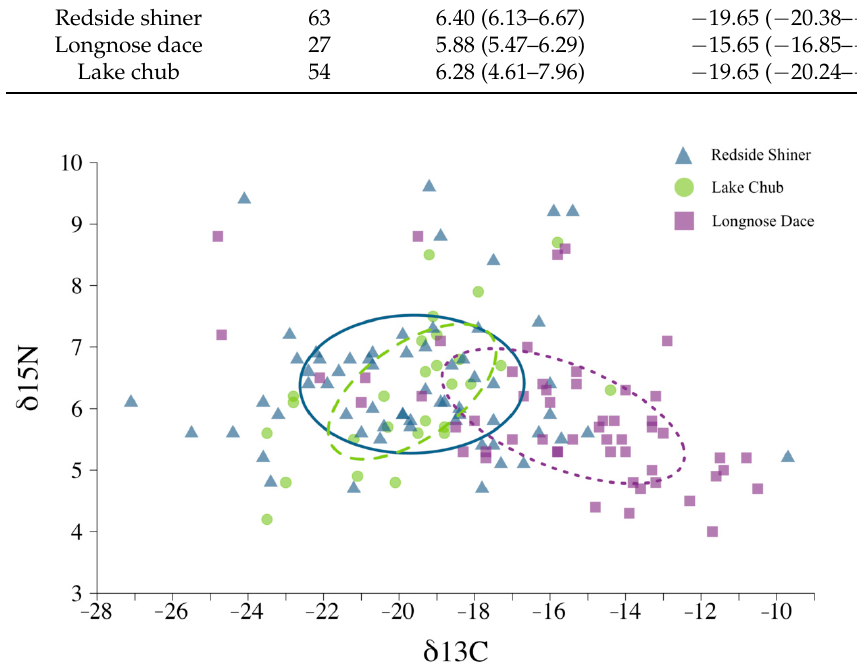
Figure 2. Stable isotope biplot of redside shiner (blue triangles), lake chub (green circles), and longnose dace (purple squares). Spheres represent 40% Bayesian standard ellipse areas for stable isotope signatures of redside shiner (blue solid), lake chub (green dash), and longnose dace (purple dot).